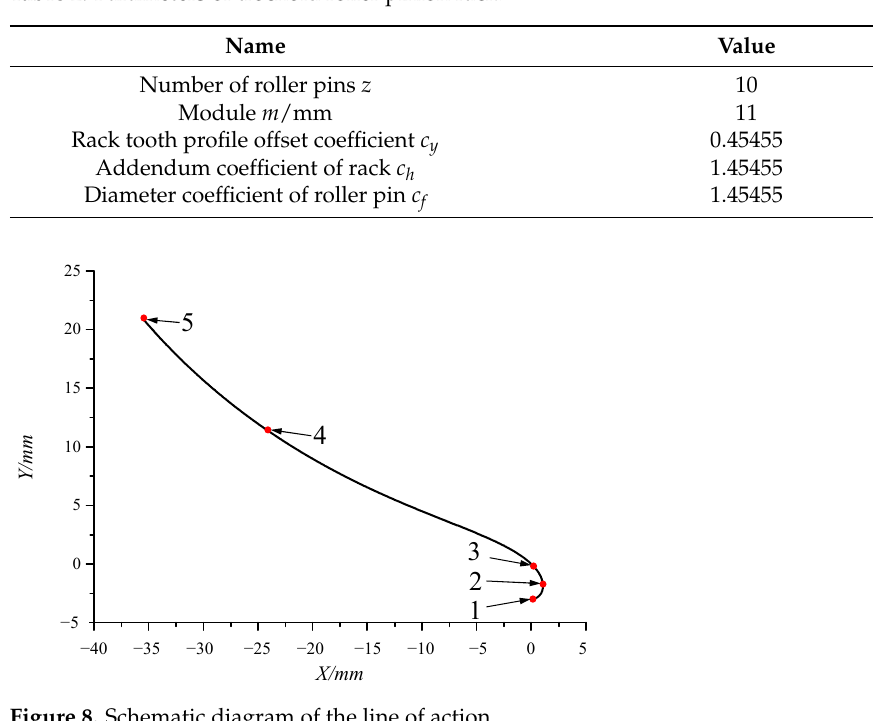
Table 2. Parameters of trochoid roller pinion rack.